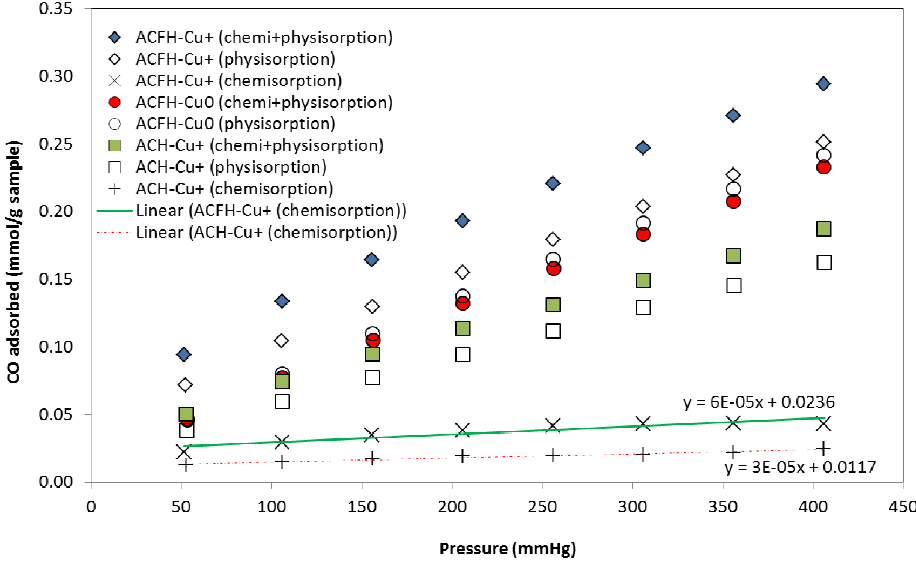
Figure 2. CO adsorption isotherms of selected copper-impregnated